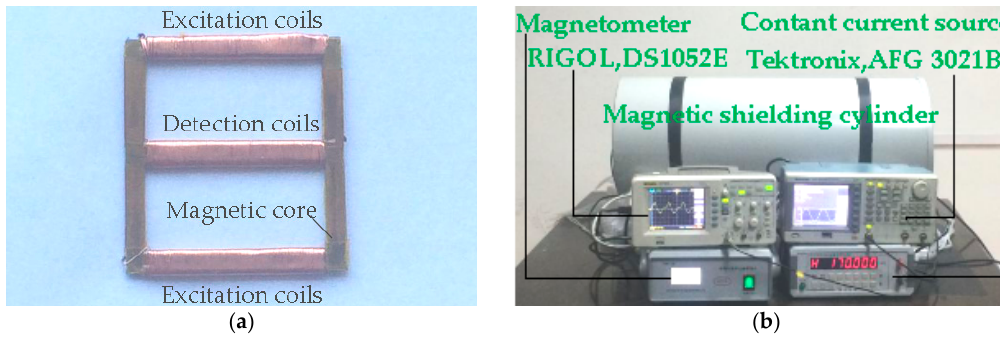
Figure 2. Image of fluxgate probe and measurements system. ( a ) Fluxgate probe; ( b ) Measurements of fluxgate probe.